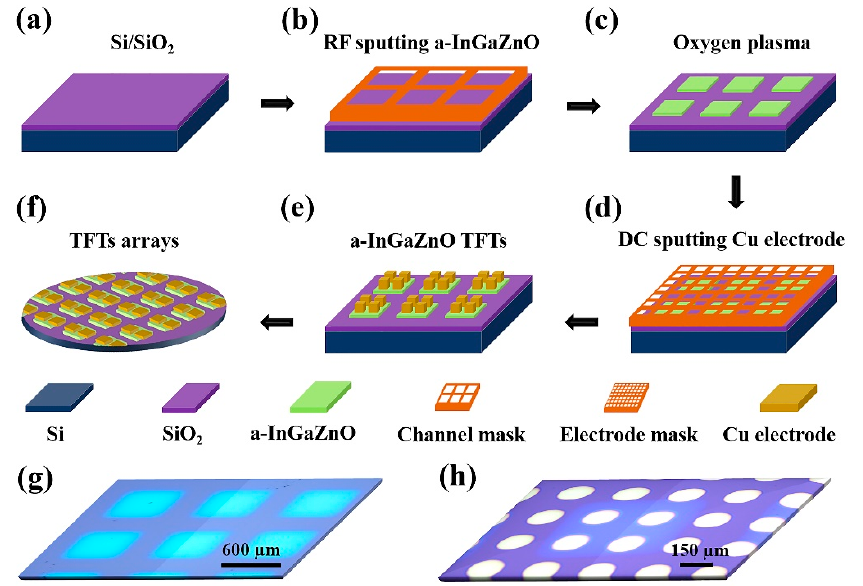
Figure 1. Schematic diagram of the fabrication process of a-InGaZnO/a-InGaZnO:O TFTs: ( a ) Cleaned Si/SiO 2 substrate; ( b ) RF magnetron sputtering deposition patterned a-InGaZnO channel layer; ( c ) the a-InGaZnO channel layer, treated with oxygen plasma; ( d ) patterned Cu electrodes deposited by DC sputtering; ( e ) patterned a-InGaZnO/a-InGaZnO:O TFTs; ( f ) TFTs arrays; ( g ) Olympus microscope images of channeling layer and ( h ) a-InGaZnO TFTs.